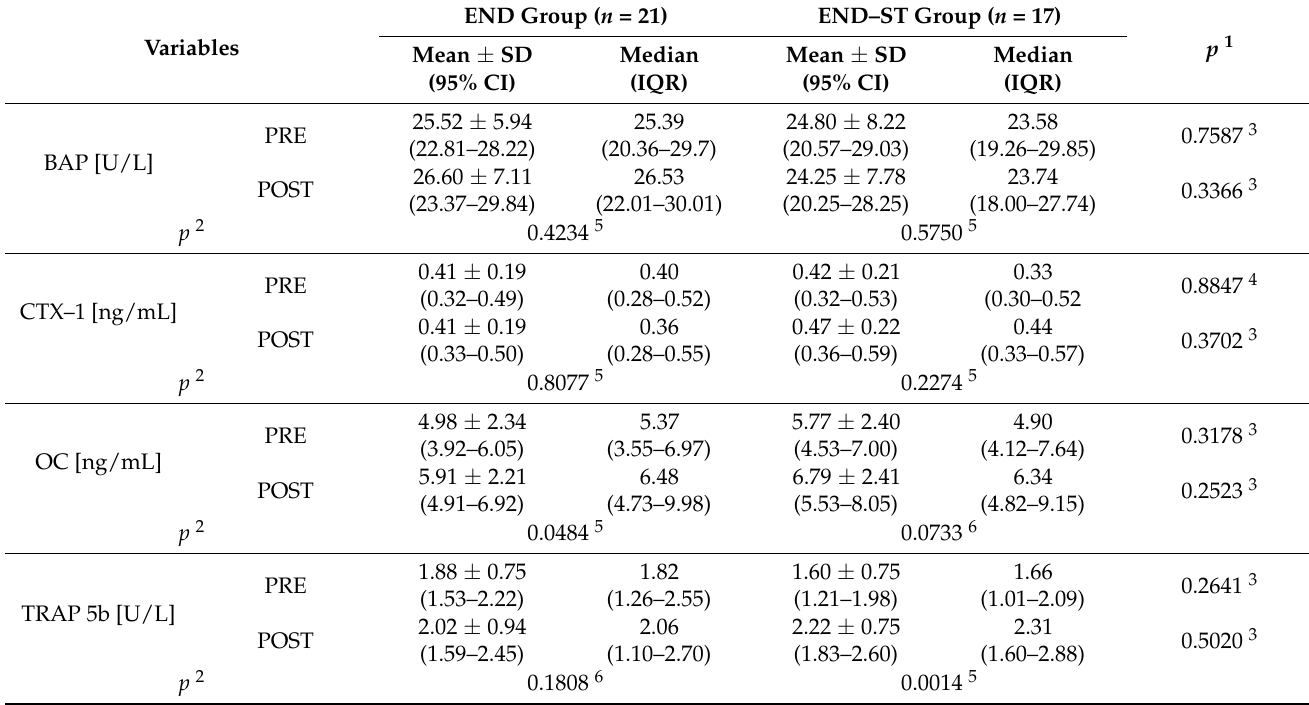
Table 2. The effect of training programmes on bone turnover marker levels.